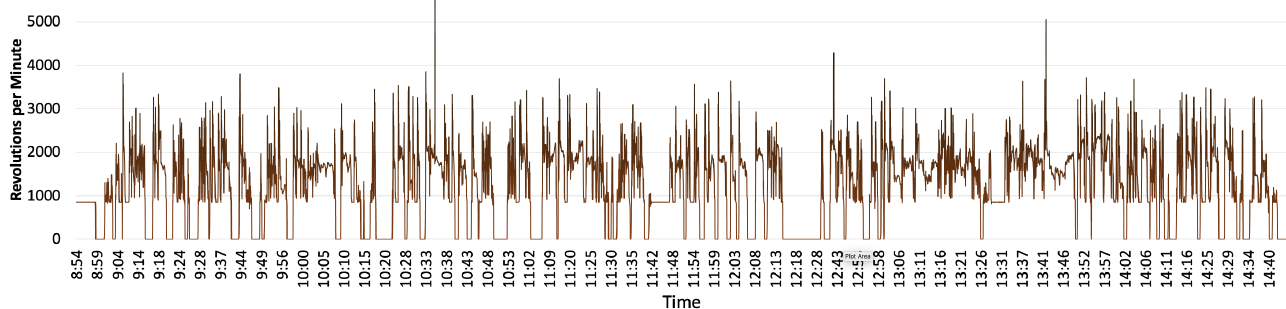
Figure 8. Engine’s RPM data collected during the